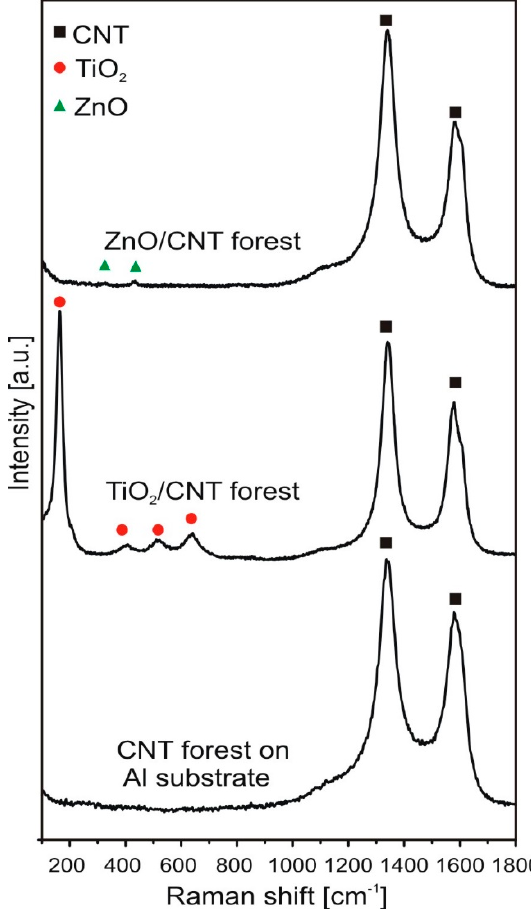
Figure 4. Raman spectra of the samples. Table 2. I D /I G ratios, D and G shifts of the samples (b.HT: Before heat treatment; a.HT: After heat treatment).